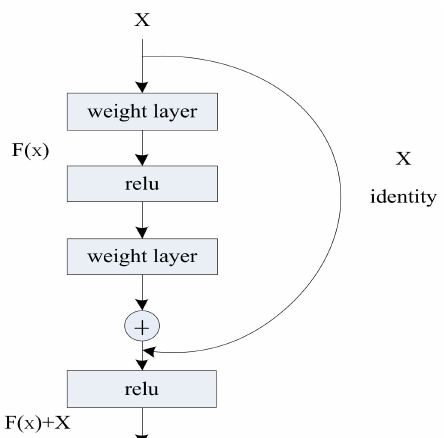
Figure 5. The structure of the residual block. It is easier to approximate an identity map by introducing a residual function F(x) = H(x) − X. The “short connection” X introduced makes the gradient back-propagation smoother and reduces the probability of gradient disappearance.